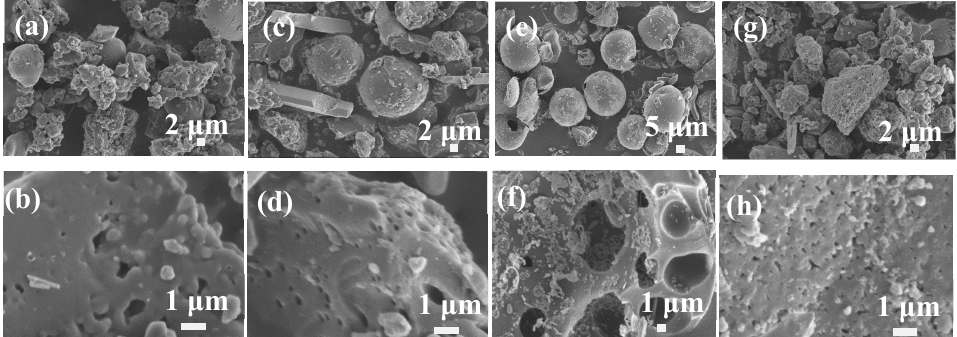
Figure 2. SEM images of lignin-based carbon materials in 40 wt% ZnCl 2 solution using four typical types as precursors: ( a,b ) Kraft lignin, ( c,d ) hydrolysate lignin, ( e,f ) alkali lignin, and ( g,h ) Longlive lignin.